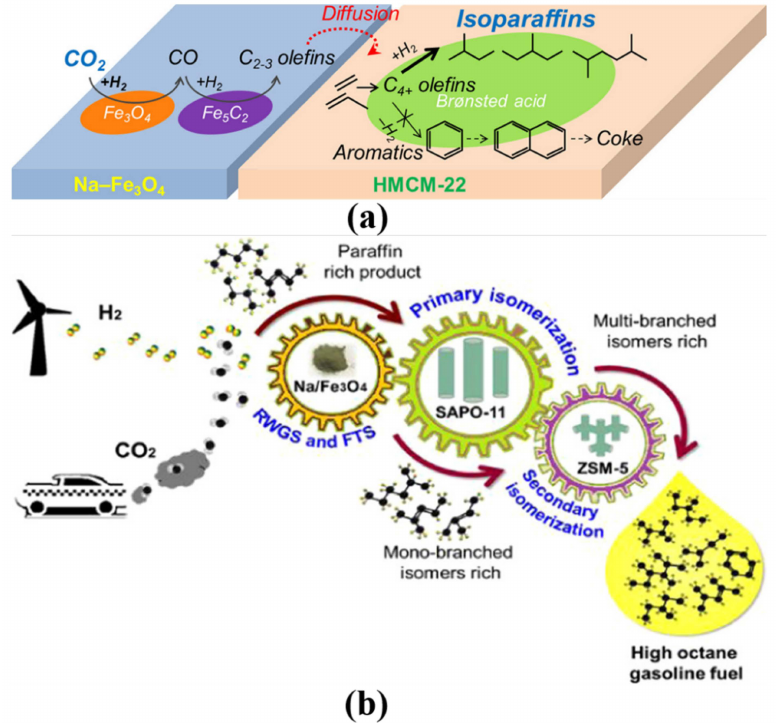
Figure 7. ( a ) Reaction scheme of iso-paraffin synthesis and coke formation during CO 2 hydrogenation over Na-Fe 3 O 4 /HMCM-22 catalysts. Reprinted with permission from Wei et al. [100]. Copyright (2018) American Chemical Society. ( b ) Reaction scheme of gasoline synthesis formation during CO 2 hydrogenation over NaFe+SAPO-11 + HZSM-5 catalysts. Reprinted with permission from Noreen et al. [70]. Copyright (2020) American Chemical